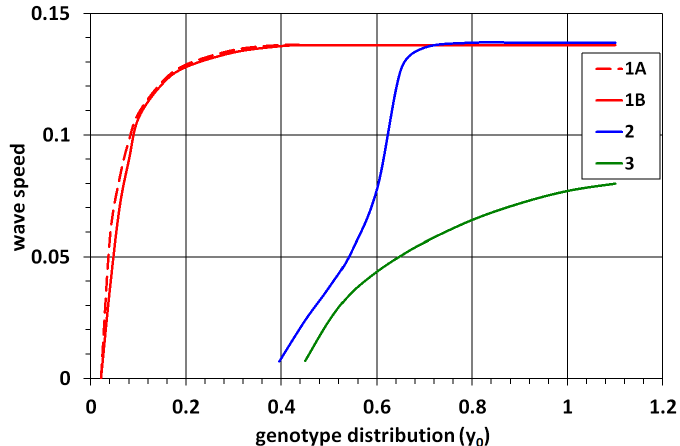
Figure 3. Wave speed for the 1D Equation (10) (dashed line) and for the 2D Equation (1) (solid lines). Curves 1 and 3 correspond to the monostable and bistable waves, respectively, for the same values of parameters, and curve 2 shows the transition from the bistable wave to the monostable wave. The values of parameters are D x = D y = 0.005, k = 1, σ 0 = 1.1, f ( v ) = a 1 ve − a 3 v , a 3 = 6, a 1 = 15 (curves 1, 3, and dashed curve), and a 1 = 13 (curve